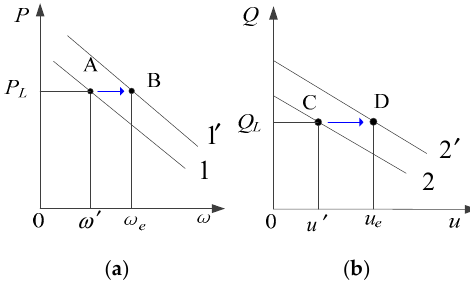
Figure 7. Droop control characteristics: secondary regulation: ( a ) secondary frequency regulation; ( b ) secondary voltage regulation.